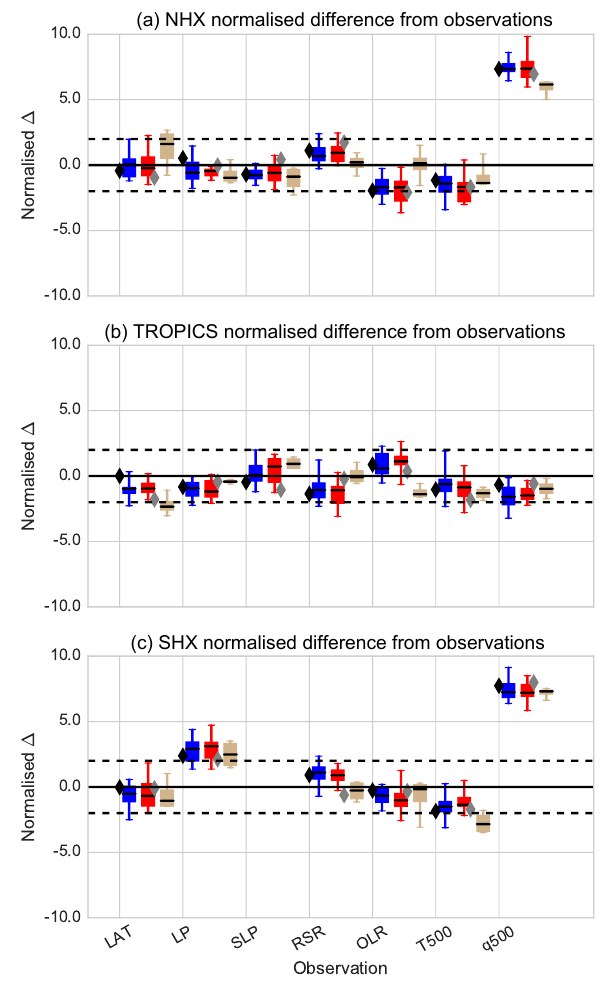
Figure 5. As in Fig. 3 except shown are differences between sim- ulated, from 2-member ensemble and observed change between 2005–2010 and 2000–2005. All values are standardised by 3 σ internal variability computed from the 100-member 2000–2005 HadAM3